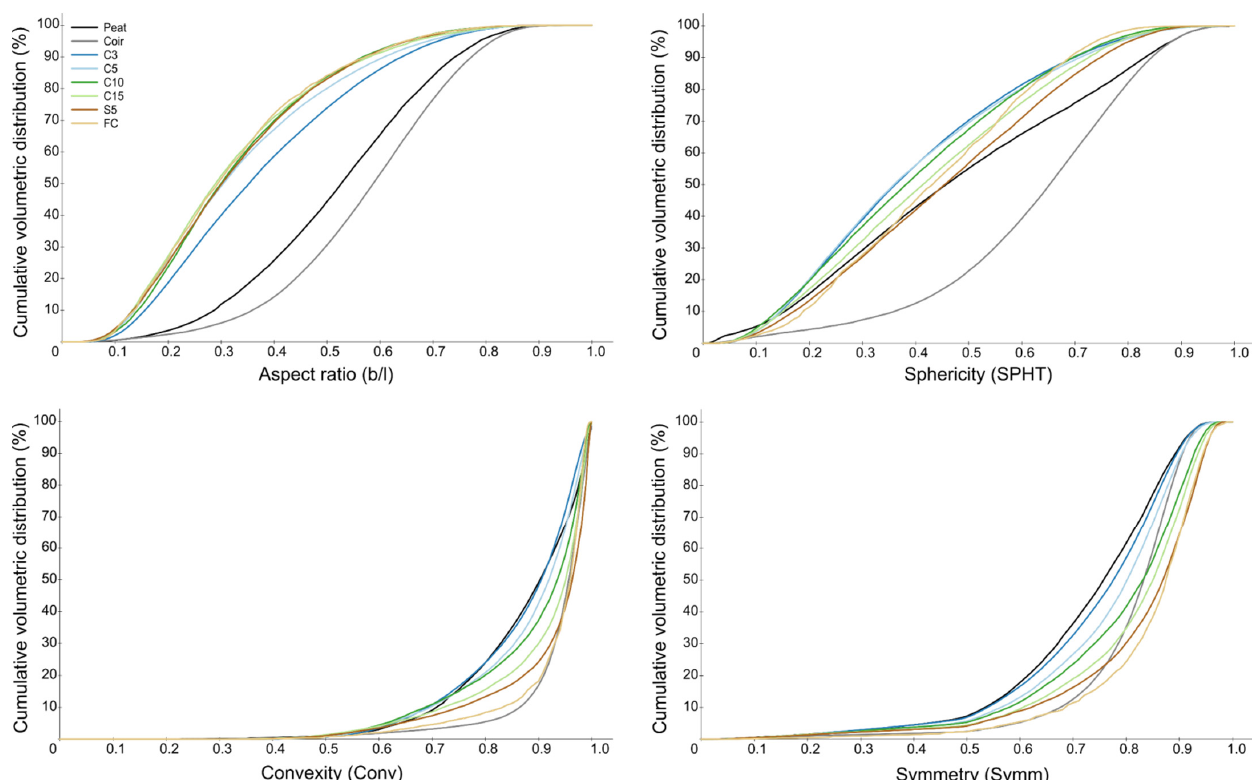
Figure 3. Volumetric distribution of particle shape of peat, coir, and processed miscanthus substrates analyzed with dynamic image analysis. The curve represents for one measurement of each substrate. Miscanthus × giganteus was harvested with a forage harvester (FC, field-chips), then processed with a mechanical fraying facility through a 5-mm screen (S5, shreds) or a hammermill with screen sizes of 15, 10, 5, and 3 mm (C15, C10, C5, and C3, chips).